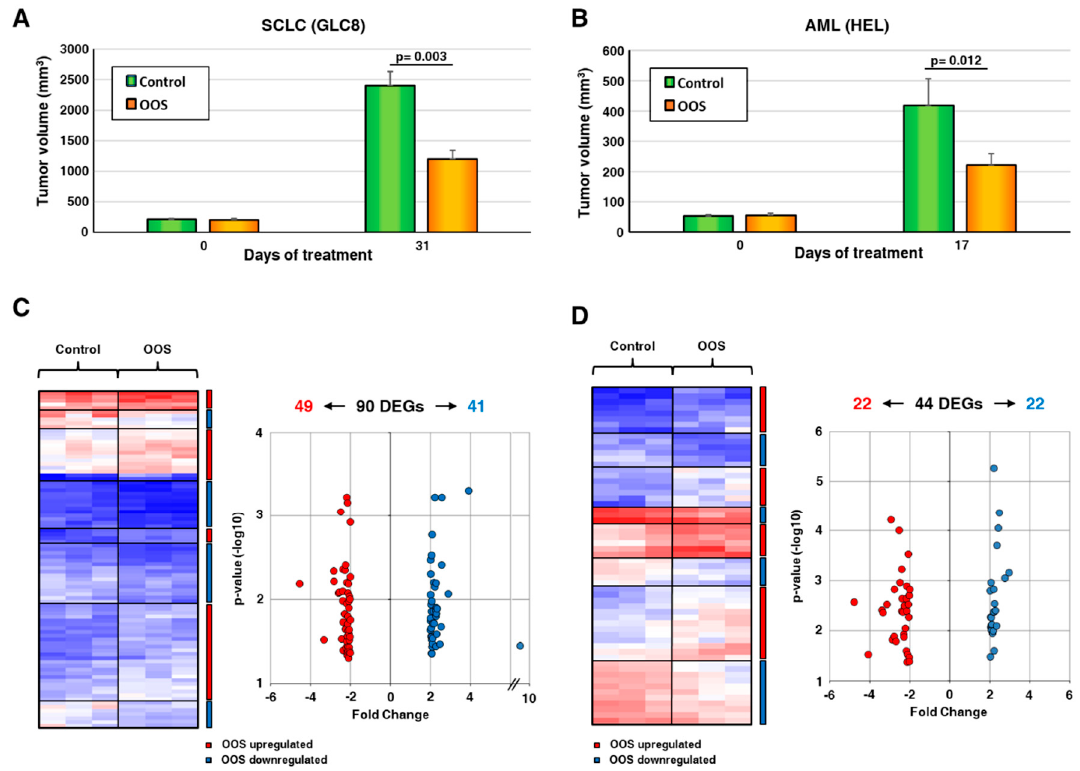
Figure 1. Ocoxin Oral Solution (OOS) transcriptomic modulation. ( A ). In vivo e ff ect of OOS on the growth of small-cell lung cancer (SCLC) tumor models. Animals were injected with GLC8 cells and, when the tumors were correctly engrafted and growing, were randomized into two groups that were daily treated with PBS (control, green) or OOS (orange). Tumor volumes at the end of the treatment were calculated. Data are represented as mean tumor volume ± SD, and statistical di ff erences are indicated. ( B ) In vivo e ff ect of OOS on tumor growth of acute myeloblastic leukemia (AML) models. Similarly, animals were injected with HEL cells, and tumor growth was followed after OOS daily treatment. ( C ) RNA from three di ff erent SCLC tumors for each condition was prepared and analyzed by A ff ymetrix arrays, as described. Di ff erentially Expressed Genes (DEG) with a minimum of two-fold change di ff erential expression and a maximum 0.05 p value after OOS treatment are shown. Overexpressed genes are displayed in shades of pink-red, and downregulated genes in shades of blue. ( D ) A similar approach was used to analyze AML-derived